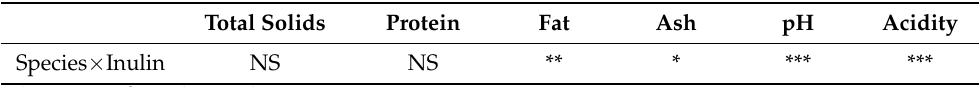
Figure 3. CIEL*a*b* color parameters of ewe’s and goat’s yoghurts produced with UF concentrated cheese whey. Different letters indicate significant differences ( p < 0.05) between components of ewe’s and goat’s yoghurts. Table 3. Interactions between species and inulin addition observed in chemical composition and pH of frozen